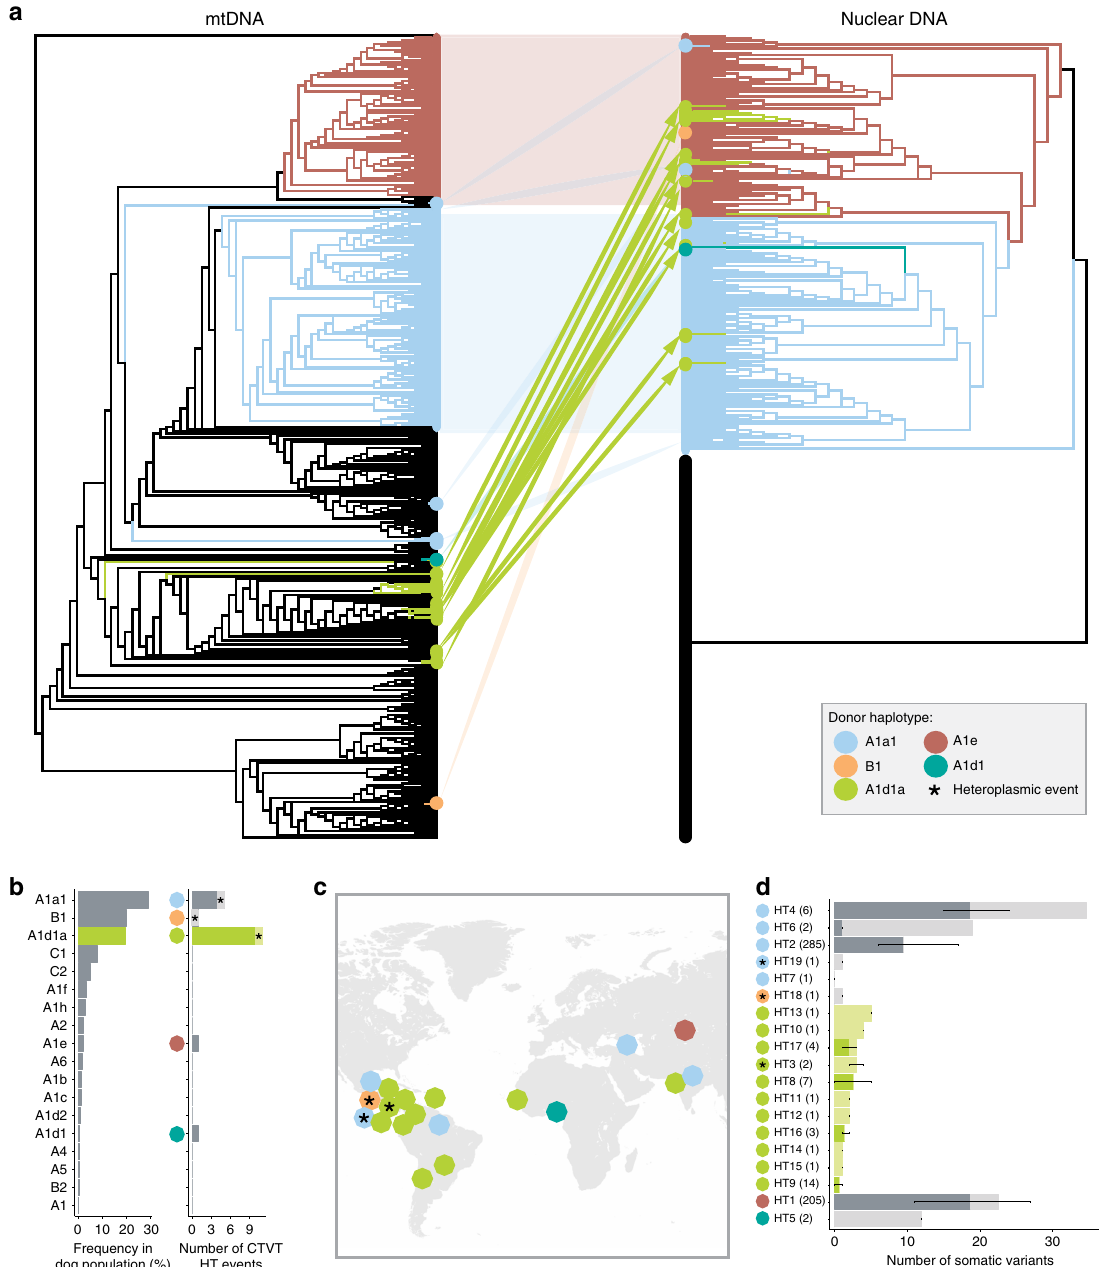
Fig. 1 Recurrent and recent horizontal transfer of canine mitochondrial haplotype A1d1a. a MtDNA (left) and nuclear DNA (right) maximum likelihood phylogenetic trees for 539 CTVT tumours (coloured) and 494 dogs (black). Correspondence between equivalent CTVTs on mtDNA and nuclear trees is indicated and coloured by mtDNA donor haplotype. Trees are presented as cladograms without informative branch lengths. High resolution trees are presented in Supplementary Figs. 1 and 2. b Frequencies of 18 canine mtDNA haplotypes within a representative global CTVT host dog population ( n = 495) (left), and the number of CTVT horizontal transfer (HT) events involving each haplotype in a population of 539 CTVTs (right). Donor haplotype (coloured dots) and heteroplasmic horizontal transfer events (asterisks (*) and lighter shading) are shown. Heteroplasmic tumours carry both the parental and introduced haplotype. The A1d1a heteroplasmic horizontal transfer event involves mtDNA recombination. Bars representing A1d1a are highlighted in green. c Inferred geographical locations of 19 CTVT mtDNA horizontal transfer events. Each horizontal transfer is represented by a dot coloured by donor haplotype. If all CTVTs arising from a horizontal transfer were sampled at the same location, then this was inferred as the location of the horizontal transfer. If CTVTs derived from the horizontal transfer were found in several locations, then the likely site of the horizontal transfer was inferred based on phylogenetic information 12,13 . Heteroplasmic horizontal transfer events are indicated with an asterisk (*). d Number of somatic mtDNA mutations acquired since each horizontal transfer (HT) event. Number of CTVTs ( n = 539) belonging to each HT event is indicated. Bars are split into two categories: darker colour shades represent con fi dent somatic mutations that are polymorphic within each HT group, with error bars representing the mutation range; lighter colour shades represent variants that are fi xed within each HT group, whose somatic or germline status cannot be determined (see Methods). Bars representing A1d1a HTs are highlighted in green. Donor haplotype (coloured dots) and heteroplasmy (asterisk, *) are